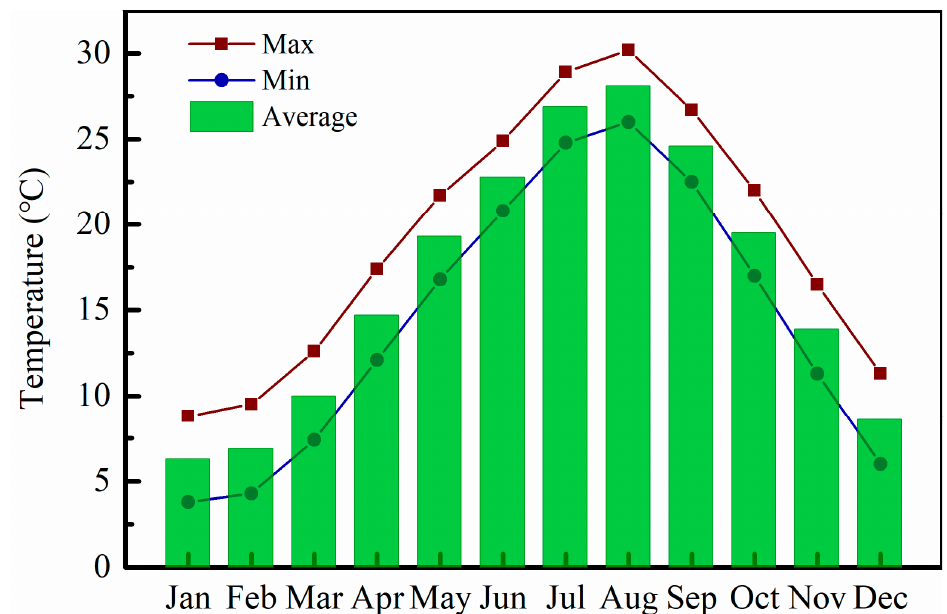
Figure 3. Monthly temperature distribution of Kitakyushu in the past 30 years (data from Japan Meteorological Agency).